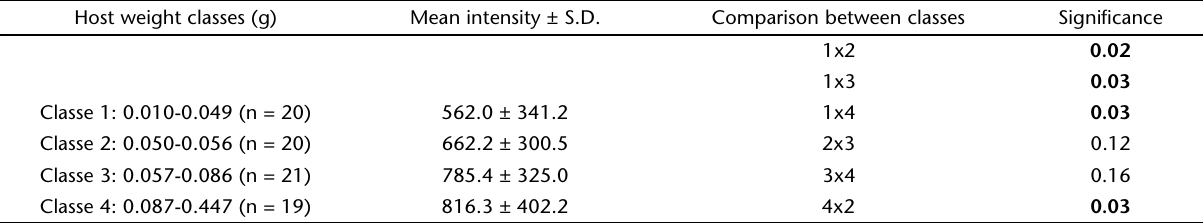
Table I. Mean intensity followed by standard deviation of Trichodina heterodentata on Rhinella pombali tadpoles weight classes. Statistical Kruskal-Wallis test (non-parametric ANOVA) was used to determine significant differences between the classes (p < 0.05 = classes differ